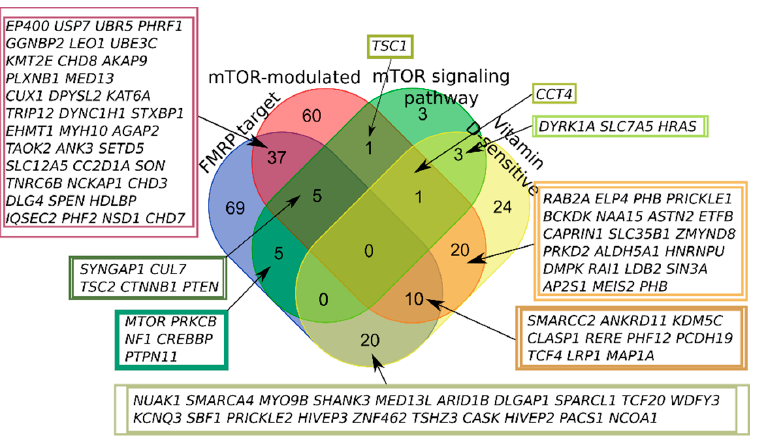
Figure 1. Venn diagram representing the relationship of the four categories related to the mTOR signaling and vitamin D-sensitive genes. All sets of genes were preliminarily intersected with high-scored candidates from the SFARI Gene database.